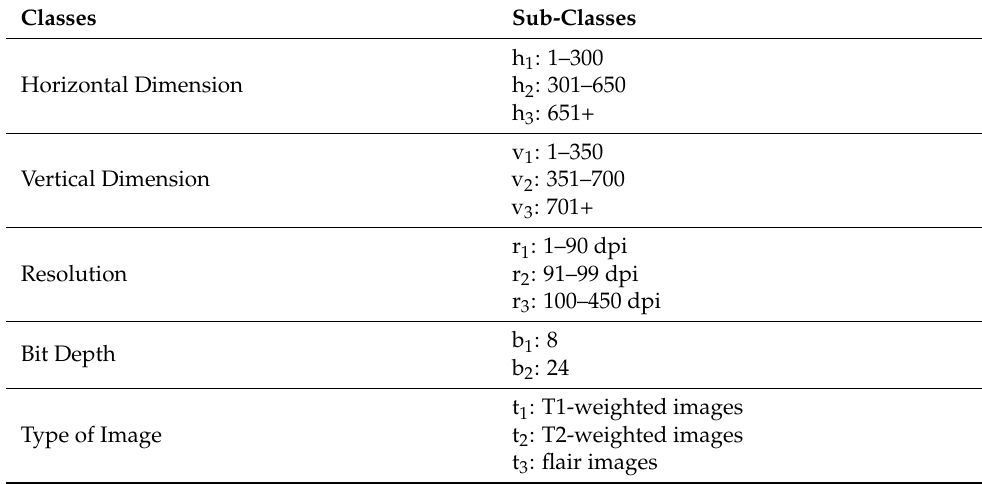
Table 2. Classes using strong equivalence class testing.